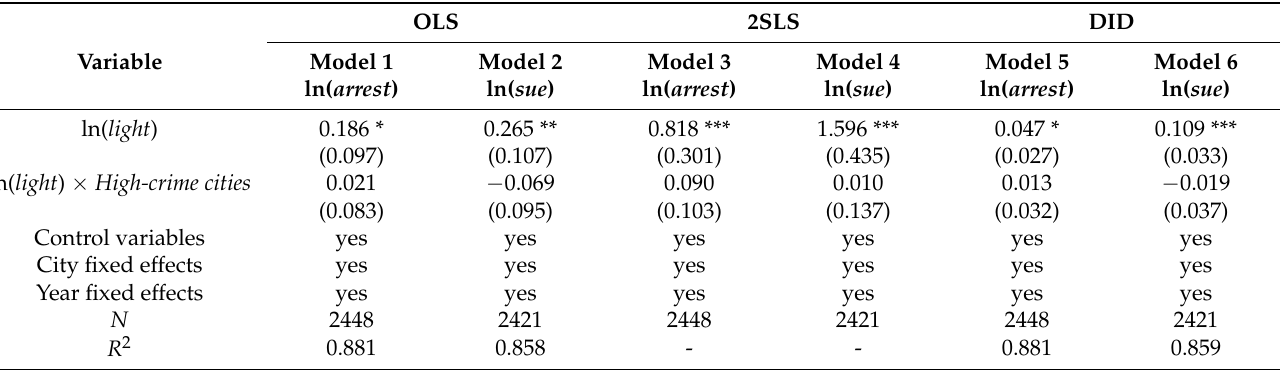
Table 5. Regression results based on crime rate